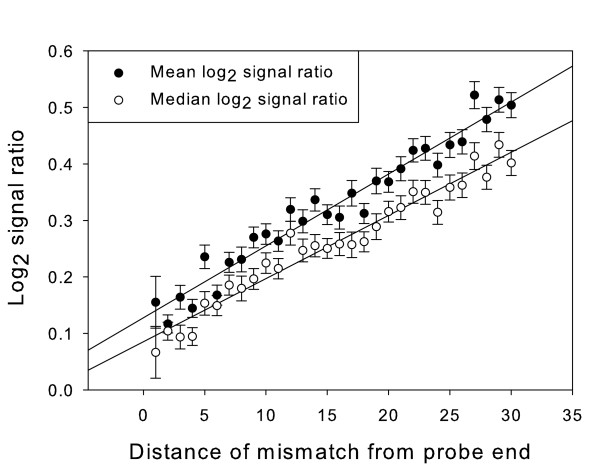
Log2 signal ratio for duplexes containing 1 mismatch, in each possible mismatch position. Mismatch position is measured in base pairs from the nearest end of the probe. The lines show the result of linear regression over the mean value for each position and the median value for each position. Error bars represent the standard error of the mean.